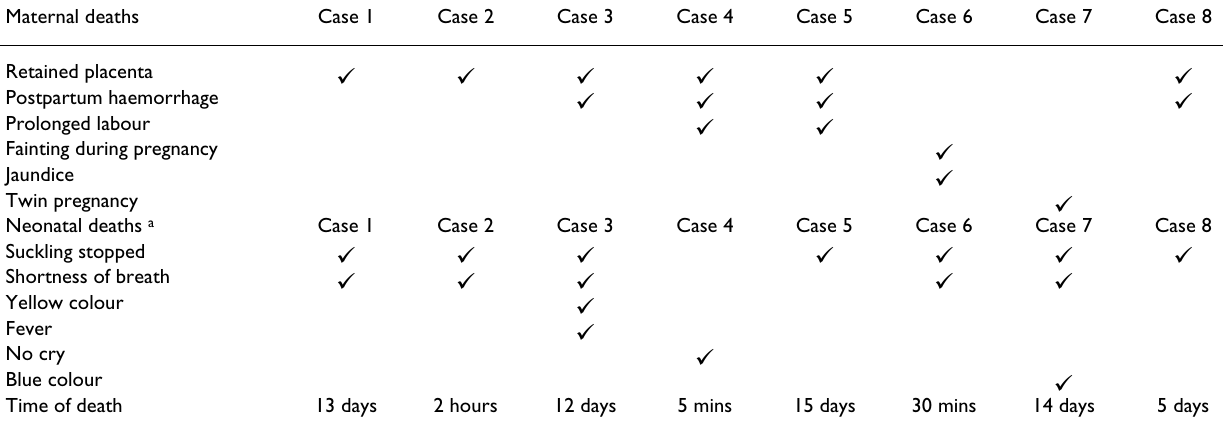
a Two case studies of neonatal deaths have been omitted from this table, since they were felt to be exceptional. In one case, the baby died in hospital after operative delivery. In the other, preterm twins died shortly after